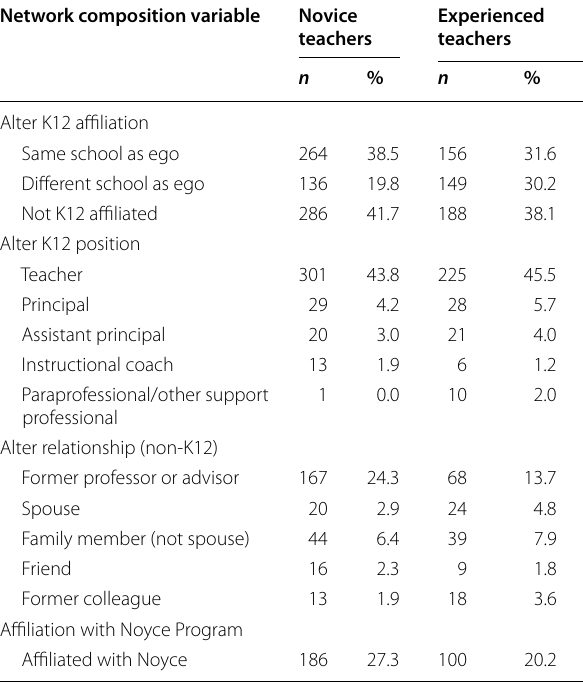
Table 2 Comparing network composition among novice